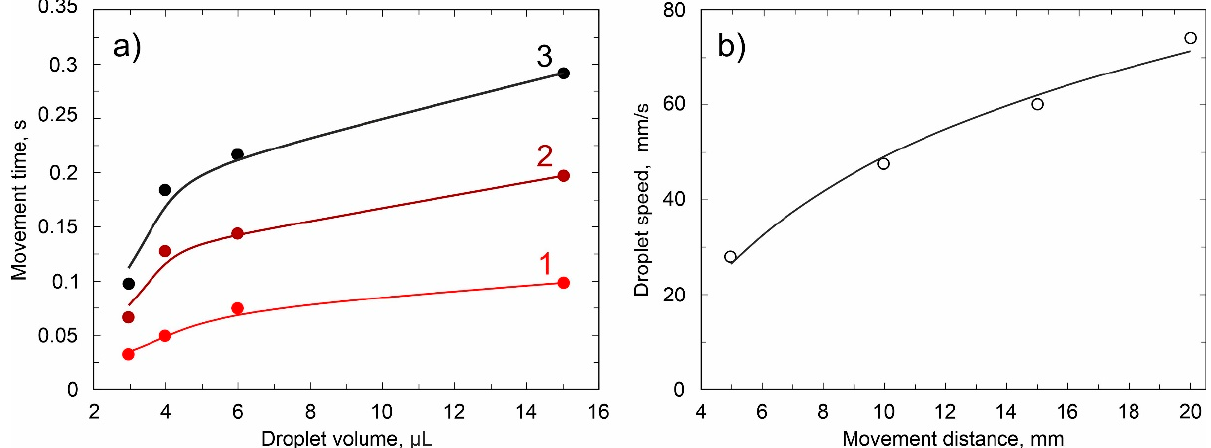
Figure 4. Characteristic times and velocities of droplets movement in different modes. ( a ) forward movement time t trans (curve 1), oscillation damping time t vibr (curve 2) and total droplet movement time t pass (curve 3) by one step as a function of droplet volume V d ; ( b ) average droplet velocity ( V d = 4 µL) depending on the distance in the case when selected control electrodes are simultaneously switched on.